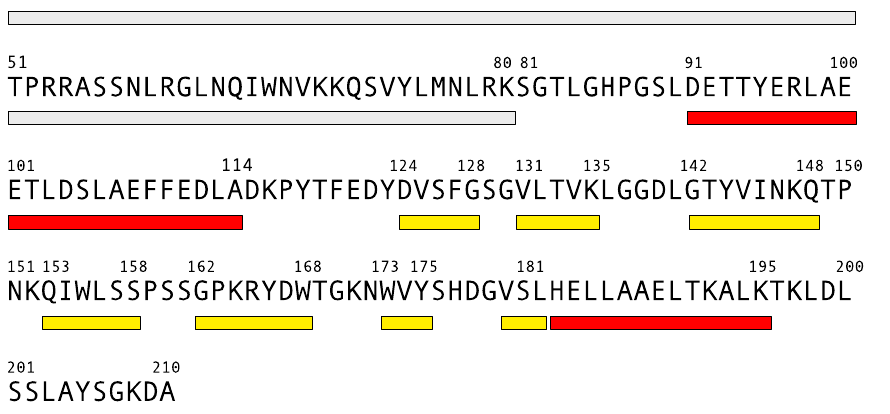
Figure 1. Human frataxin sequence and secondary structure, as reported for PDB 1EKG. Rectangles report the mitochondrial targeting signal and a spacer (gray), α -helices (red) and β -strands (yellow).